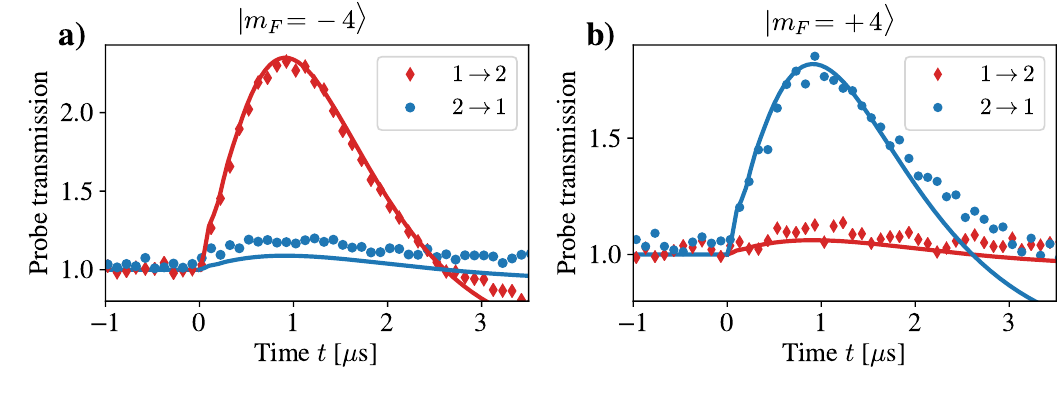
Figure 2. Non-reciprocal gain. Measured probe transmissions when launching the probe laser into port 1 or port 2 of the waveguide, see red diamonds and blue circles, respectively. a) We prepare the atoms in | F = 4 , m F = − 4 (cid:105) . At t = 0 µ s, we switch on the coupling field and the probe transmission increases by ∼ 130% in the 1 → 2 direction, while it is almost unchanged in the 2 → 1 direction. b) Here, we prepare the atoms in | F = 4 , m F = + 4 (cid:105) and observe that the direction in which there is gain is now switched, showcasing non-reciprocal amplification and that the gain directionality can be controlled by suitably preparing the atomic spin state. The data is in good agreement with the theory prediction, see solid